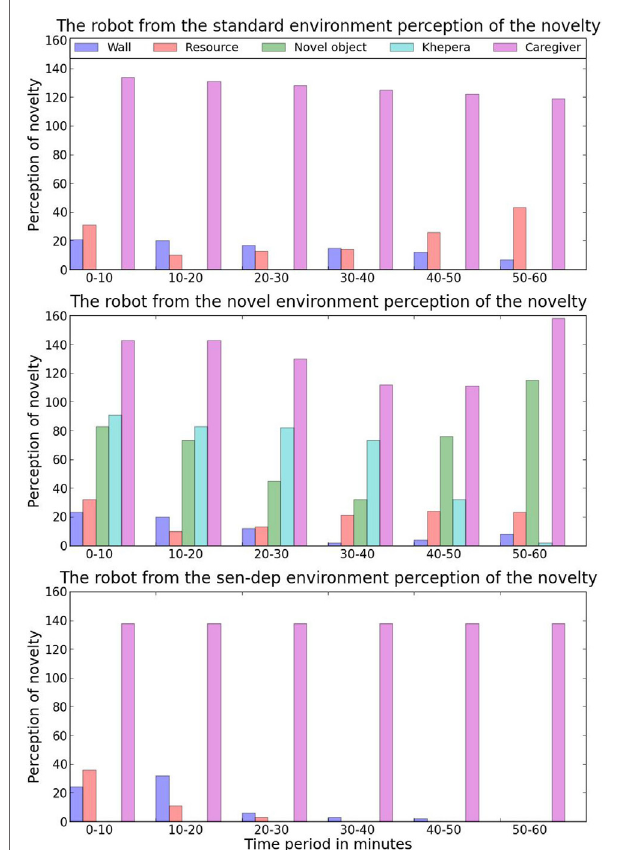
FigUre 9 | an overview of the average perceived novelty of 5 different aspects of the robot’s environment during each time period . It should be expected that as a robot interacts with an aspect the novelty value will decrease. The exception to this is if the object has unpredictable or dynamic behavior in which case the novelty value would be expected to rise as the robot interacts with